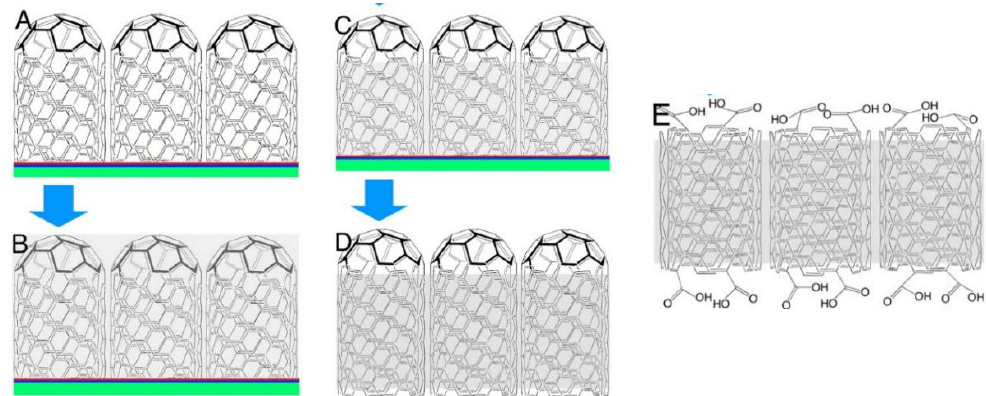
Figure 23. VANT membrane synthesis route. In green is the Si wafer, in blue an alumina support and in red an iron catalyst where the CNTs were grown ( A ); in grey the epoxy coating ( B ); tip exposure ( C ); removal of wafer and catalyst ( D ); tube opening via O 3 treatment ( E ). Reprinted with permission from Ref. [203]. Copyright 2014 American Chemical Society.